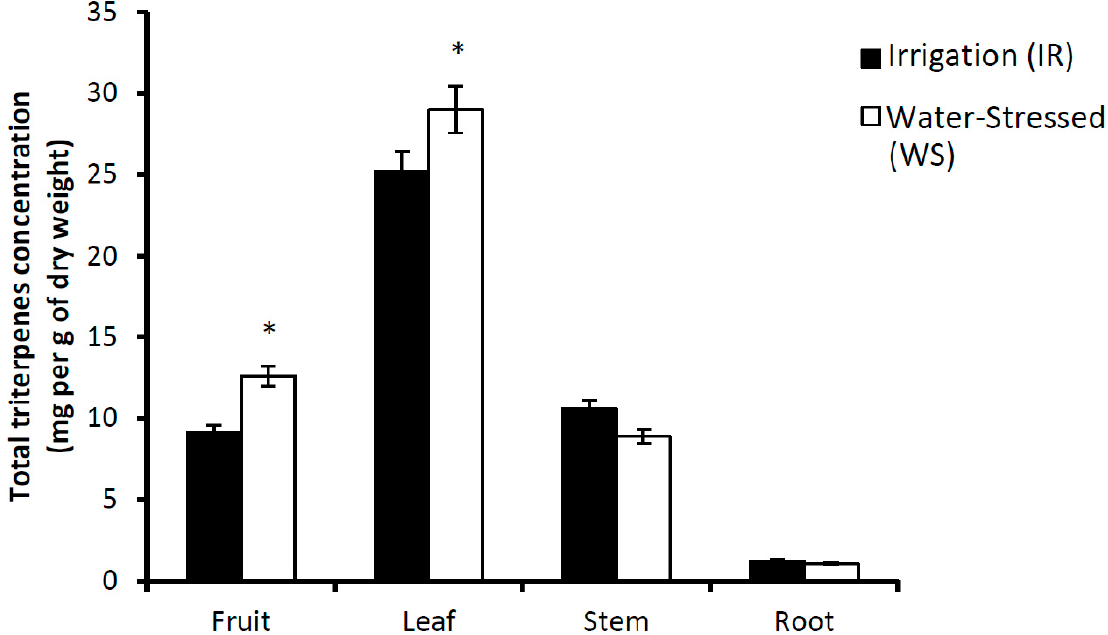
Figure 7. Concentration of total pentacyclic triterpenes found in irrigated (IR) or water-stressed (WS) cv. Picual olive tree samples. For comparisons between the irrigation and water stress conditions, * p < 0.05.